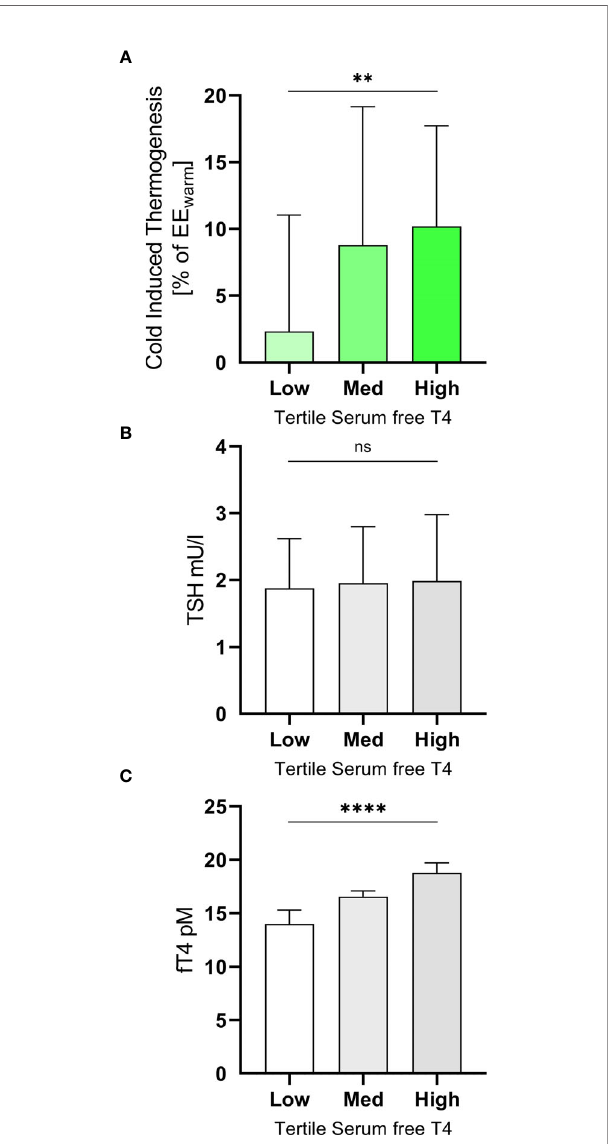
FIGURE 3 | Subjects were grouped into tertiles according their levels of free T4 (A) . The mean TSH levels of the three groups did not differ signi fi cantly (ANOVA p=0.89, (B) . In the highest tertile (free T4 17.5 to 21.0 pM) they had mean CIT of 10.2 ± 7.5% of EE warm while those in the lowest tertile (free